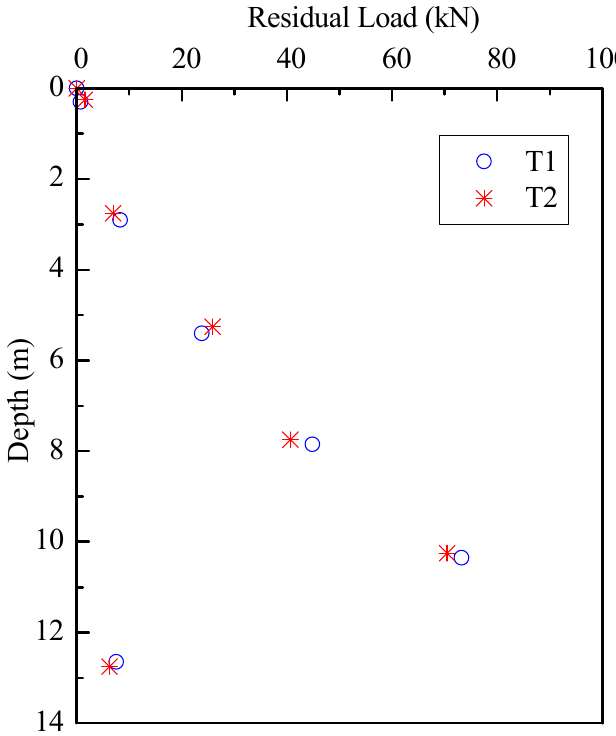
Figure 12. Residual loads distribution after installation.